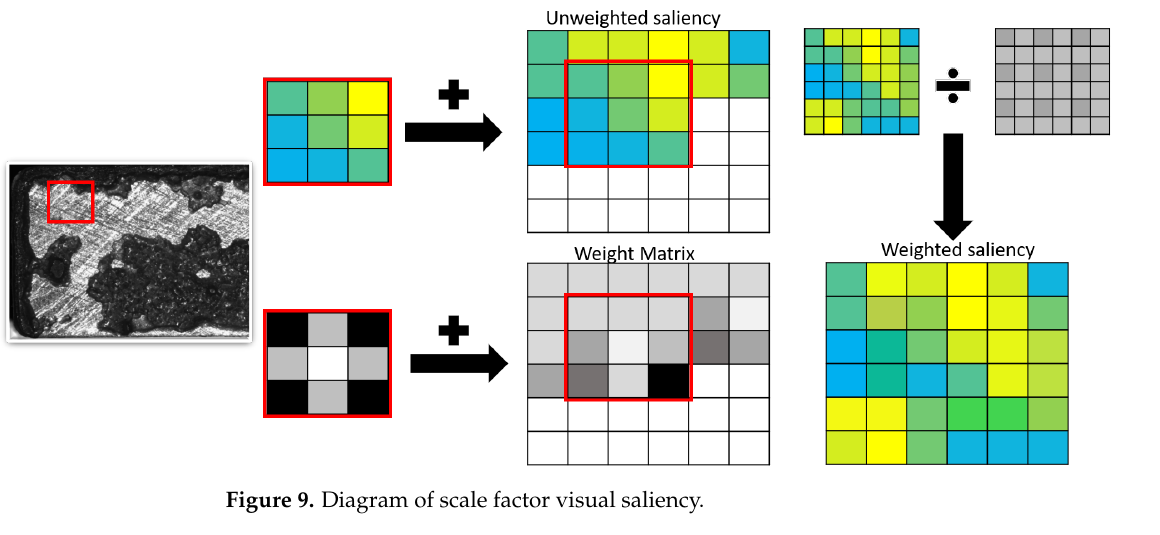
Figure 9. Diagram of scale factor visual